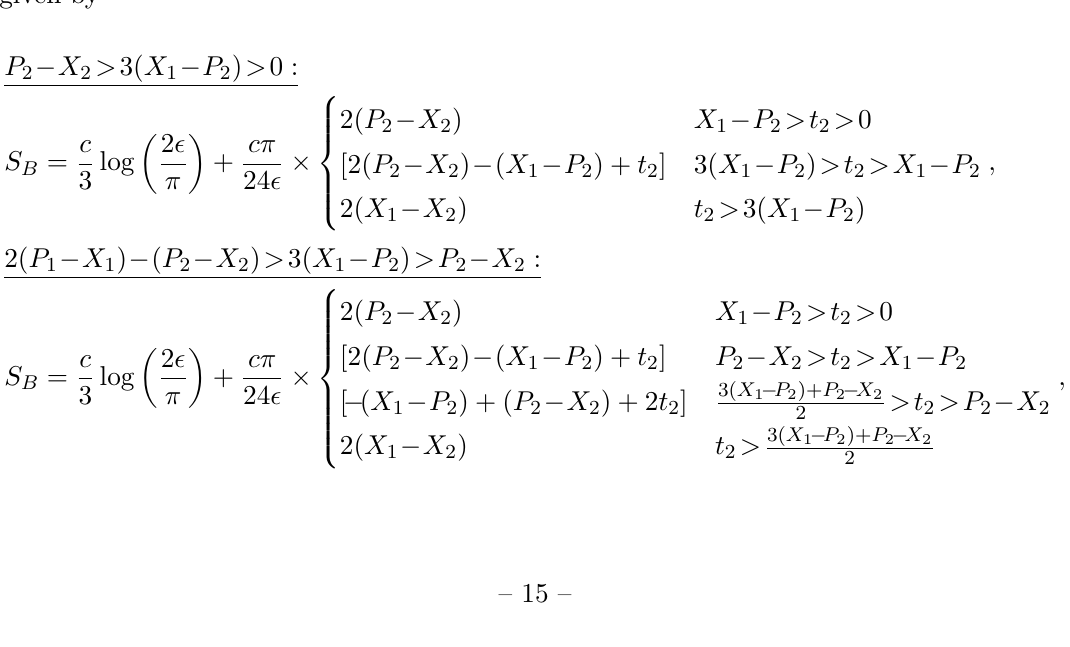
Figure 4 . The five cases which we